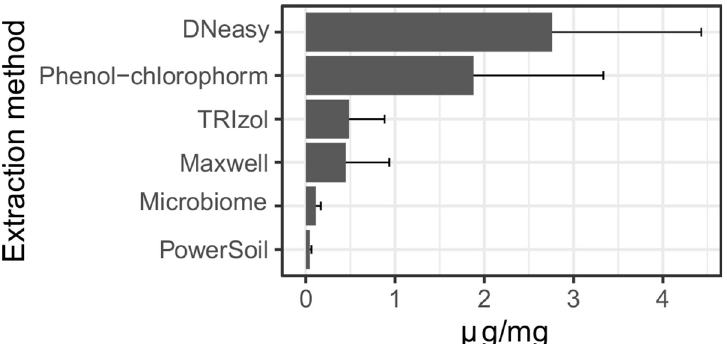
Fig 2. Total DNA yield from a fragment of mouse footpad tissue extracted by six different methods. μ g/mg refers to the total extracted DNA per milligram of mouse footpad tissue. Data are displayed as mean plus standard deviation (SD) from mouse batches processed independently. All kits were analyzed in triplicate with the exception of Microbiome, which was analyzed in duplicate.